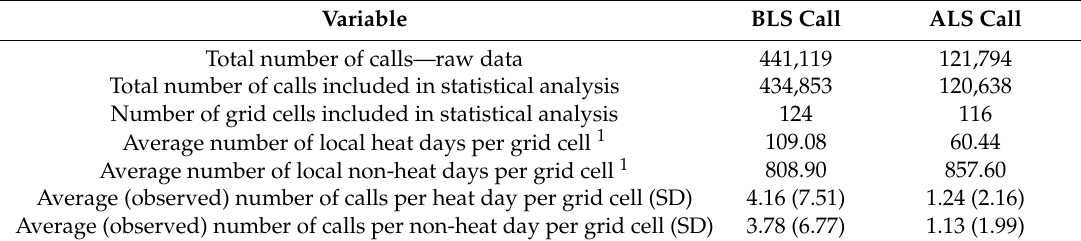
Table 1. Descriptive statistics for EMS (Emergency Medical Service) call volumes.